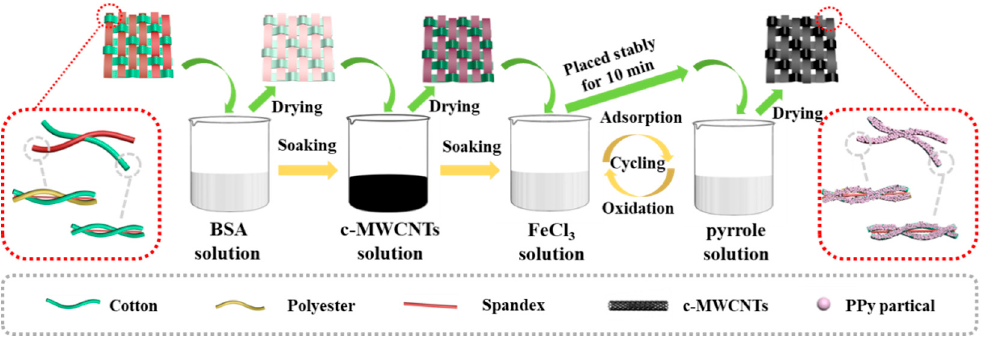
Figure 1. Schematic illustrations of fabrication procedure of DEF/c-MWCNTs/PPy strain sensor.